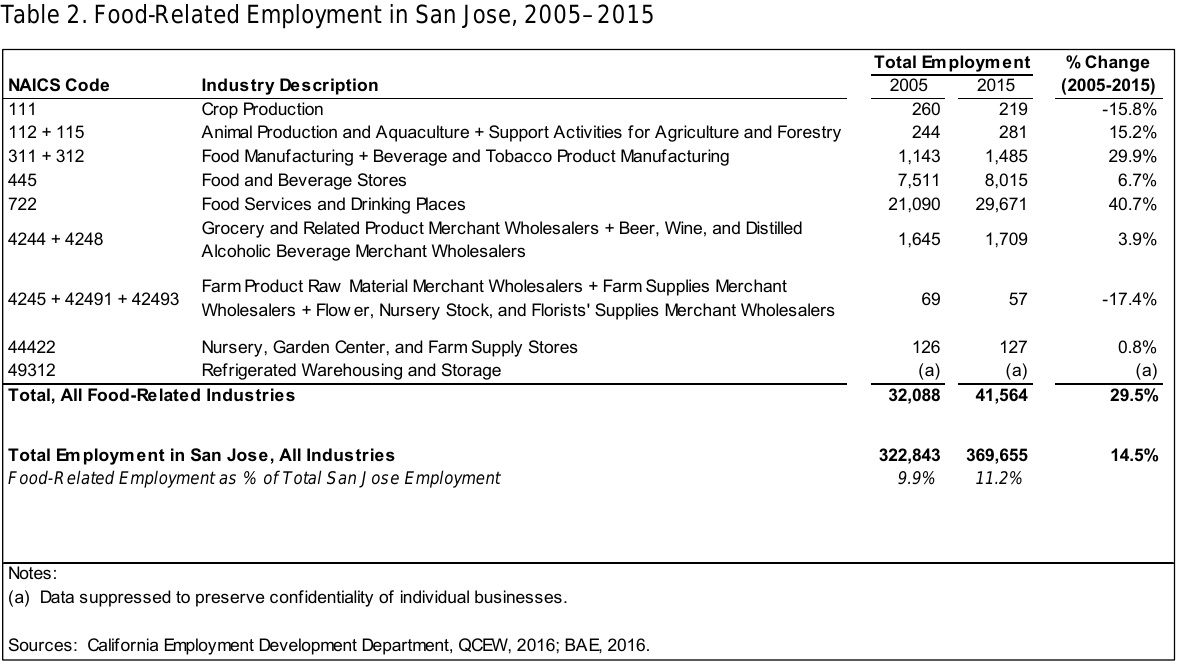
Reprinted from SAGE, 2016, Table 3.2; used with permission.